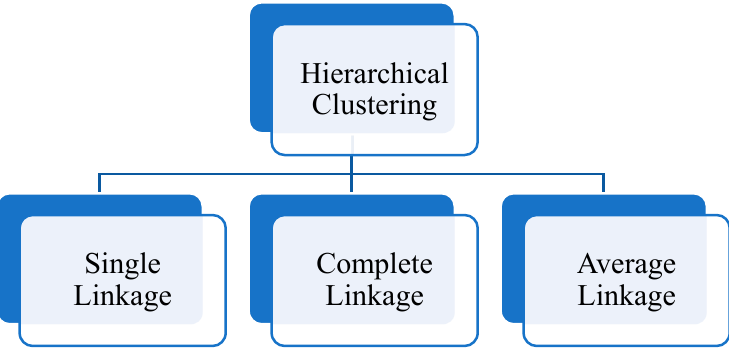
Figure 1. Hierarchical clustering mechanisms.